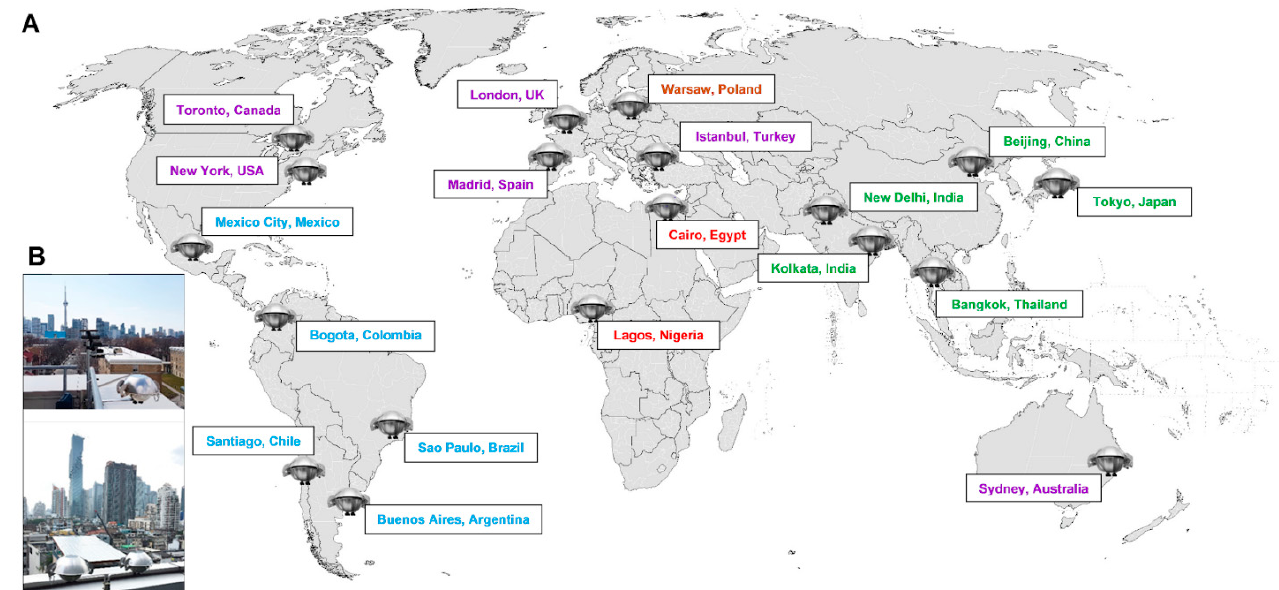
Figure 1. ( A ) Locations of polyurethane foam (PUF) passive air samplers for the GAPS-Megacities project ( n = 19). ( B ) A representative example of passive air sampler deployment. Location names are coloured based on the United Nations regional groups: Africa (red); Asia-Pacific (green); WEOG = Western Europe and Other states Group (purple); GRULAC = Group of Latin American and the Caribbean (blue); CEE = Central and Eastern Europe (orange).